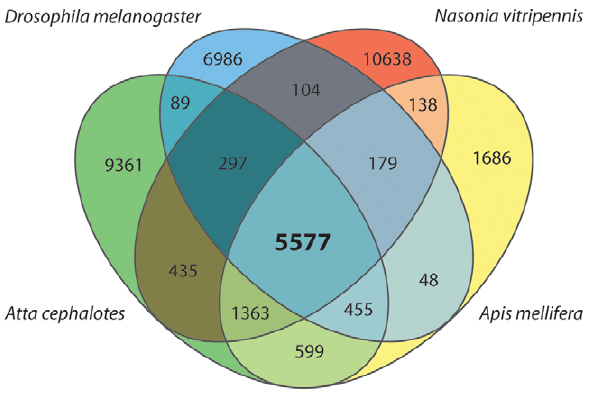
Figure 2. Orthology analysis of the Attacephalotes predicted peptide sequences (green) against the proteomes of the fly Drosophila melanogaster (blue), the wasp Nasonia vitripennis (red), and the honey bee Apismellifera